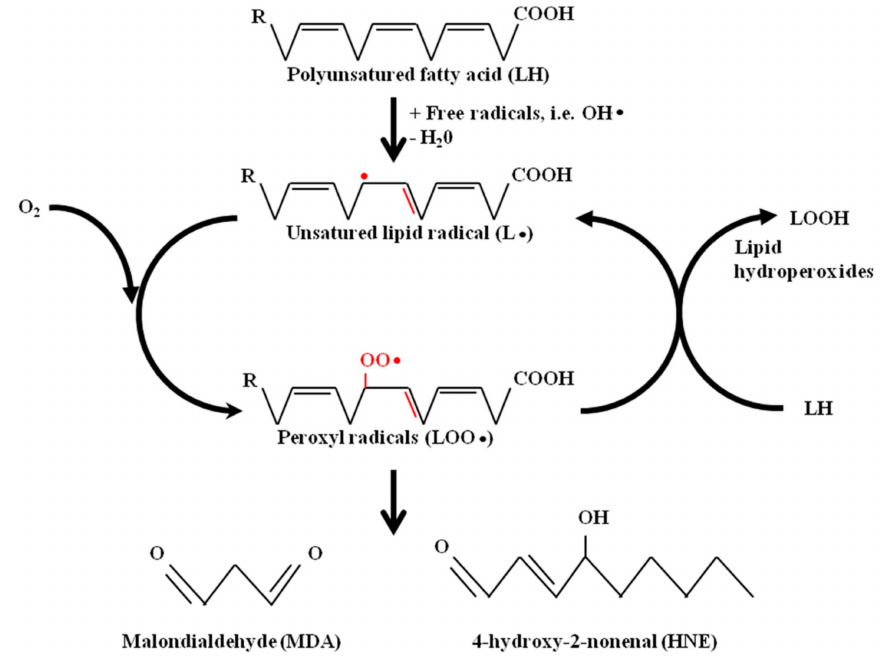
Figure 1. Malondialdehyde (MDA) and 4-hydroxynonenal (HNE) formation from polyunsaturated fatty